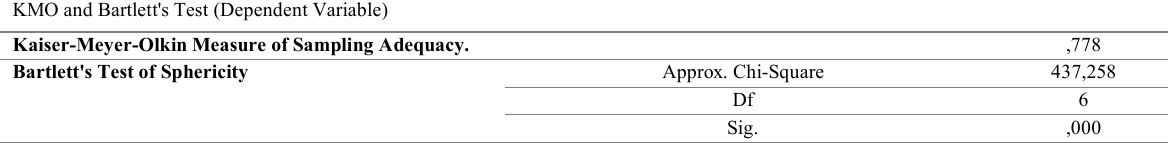
Table 3 : KMO and Bartlett’s Test for Dependent Variable